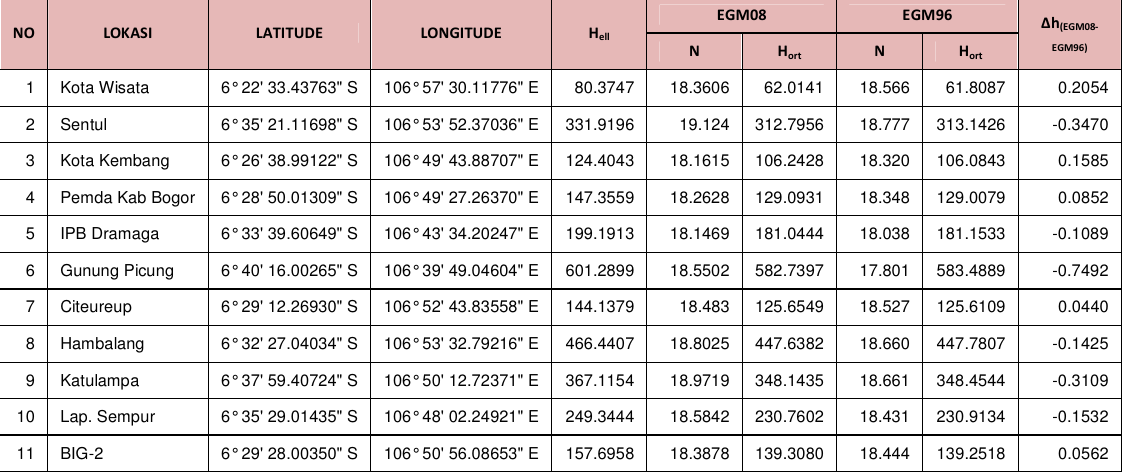
Table 4. Calculation of elevation on EGM08 and